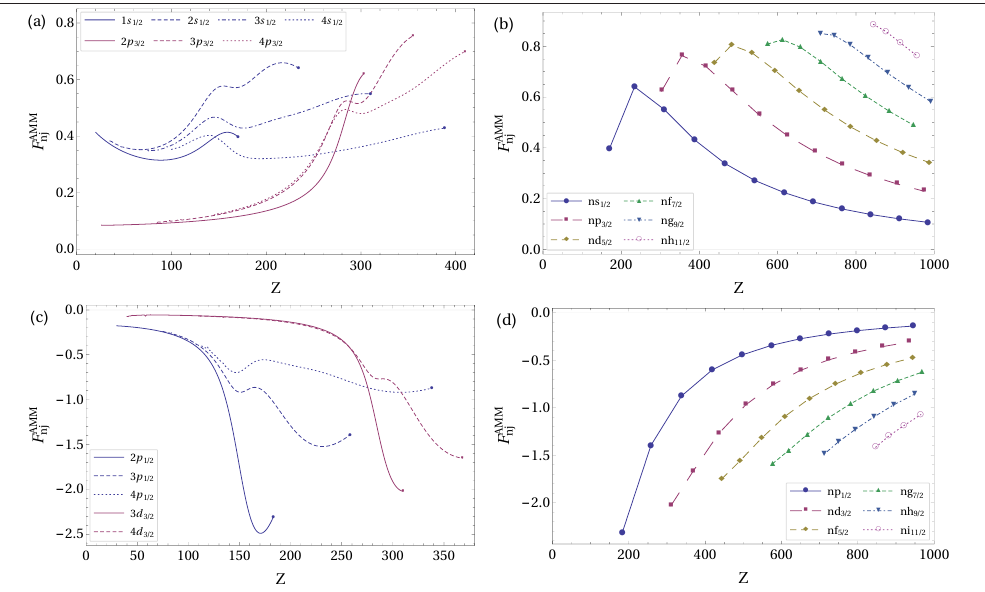
Figure 1. The shift of the levels in H-like atom due to ∆ U AMM in terms of F AMM of the nuclear charge Z for levels with n ≤ 4 and j = 1 / 2 , 3 / 2 (a),(c); F AMM levels located near the threshold of the lower continuum in the region Z < 1000 (b),(d). The separate groups of points in Figs. (b),(d) correspond to the series of the levels with fixed lj and various n